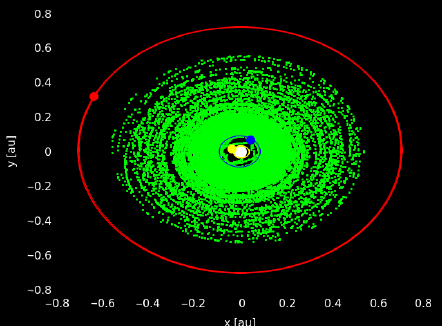
Figure 10. Luyten’s main asteroid belt in the plane at i = 0 ◦ . The main asteroid belt is located between ∼ 0.0959 au and ∼ 0.5294 au from the central star. The central core of the belt is at 0.229 au (which is the average semi-major axis of the Luyten asteroids). The majority of the asteroids have their semi-major axis smaller than the C3:1 mean-motion resonance (at about 0.3423 au), the region which contains the central